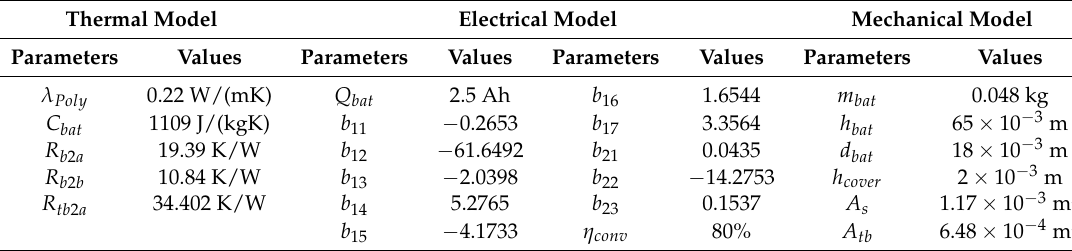
Table 1. Parameters for battery